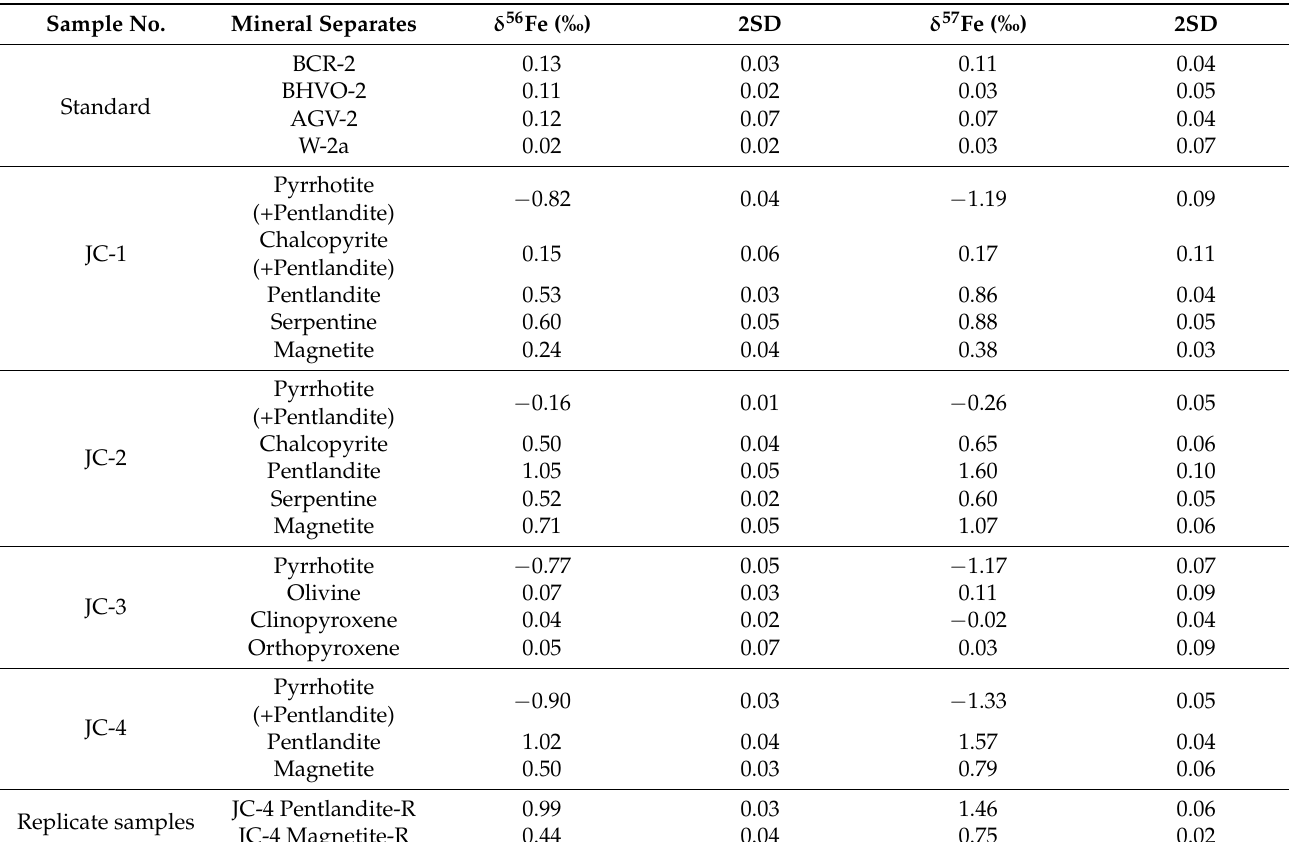
Table 5. The iron isotope compositions of sulfide, silicate, and oxide mineral separates of ore samples in the Jinchuan deposit analyzed by MC-ICP-MS. Sample